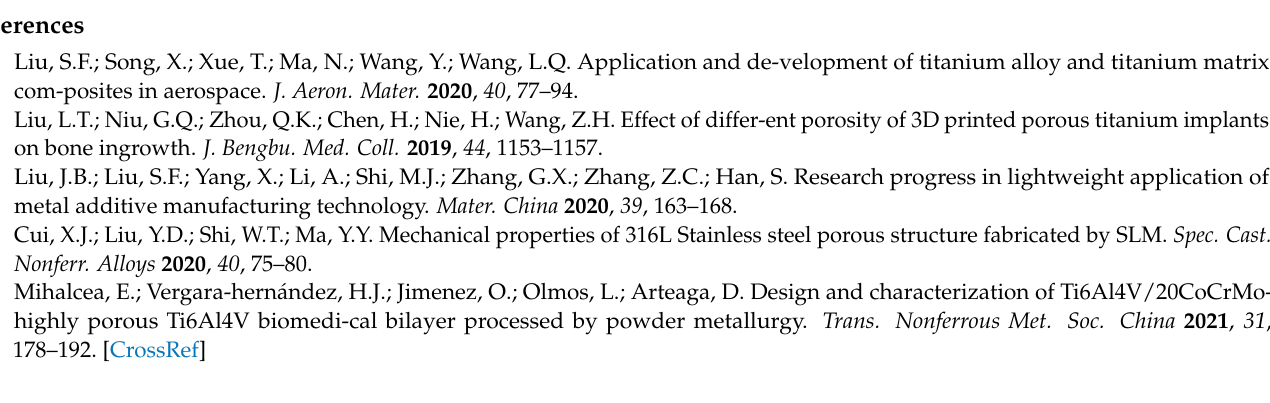
Figure 16. Porous rocker